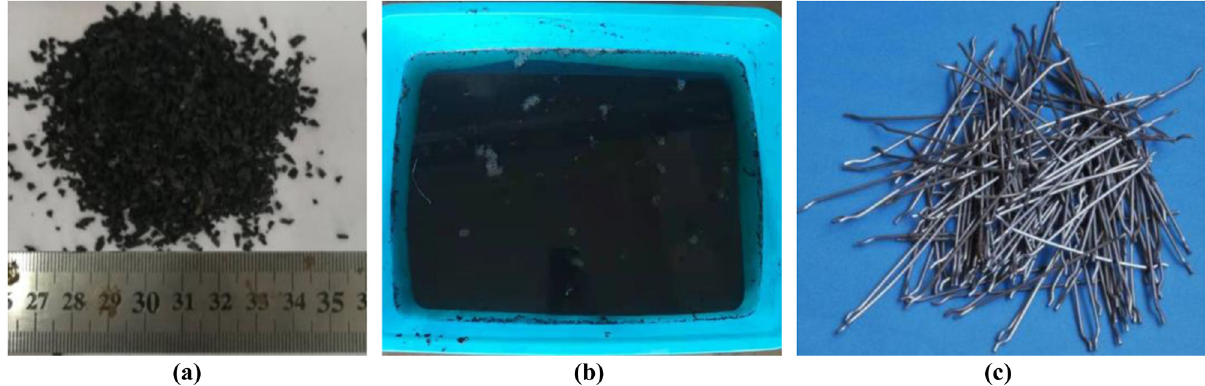
Figure 2: Rubber particles and steel fi bers. ( a ) Rubber particles; ( b ) rubber NaOH washing modi fi cation; and ( c ) steel fi